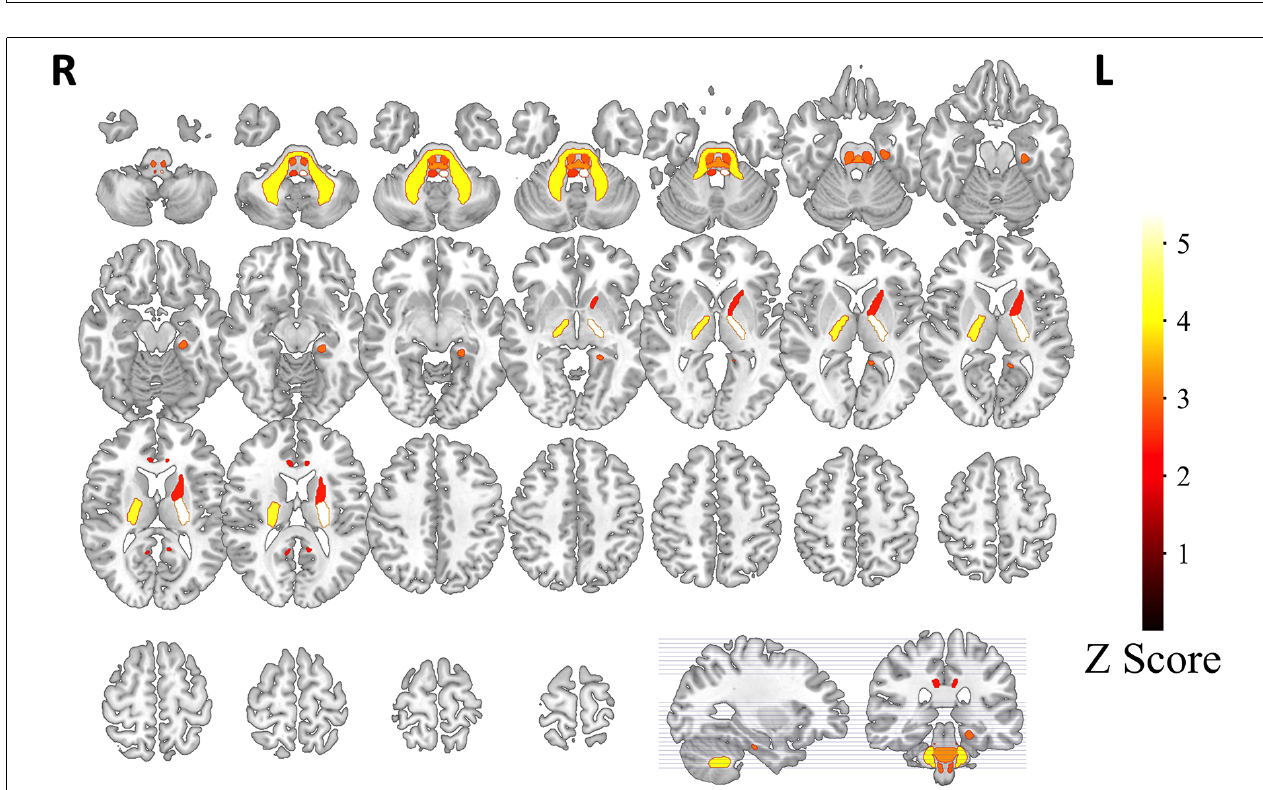
FIGURE 1 | Gait index vs. age and clinical grade. *Left panel: patients’ step length and pace are significantly correlated with age ( r = − 0.80, p = 0.001 and r = − 0.84, p = 2.96 × 10 − 4 ). Other gait indices do not show significant ( p > 0.05) correlations with age. The effects of sex and illness duration are removed. *Right panel: patients’ step length, pace, 3 m round trip time, and rising time are significantly correlated with their clinical-grade scores ( r = − 0.73, p = 0.007, r = − 0.74, p = 0.005 and r = 0.66, p = 0.021, r = 0.76, p = 0.004). Other gait indices are not significantly correlated with the clinical grade scores ( p > 0.05). Age, sex, and illness duration effects are removed.